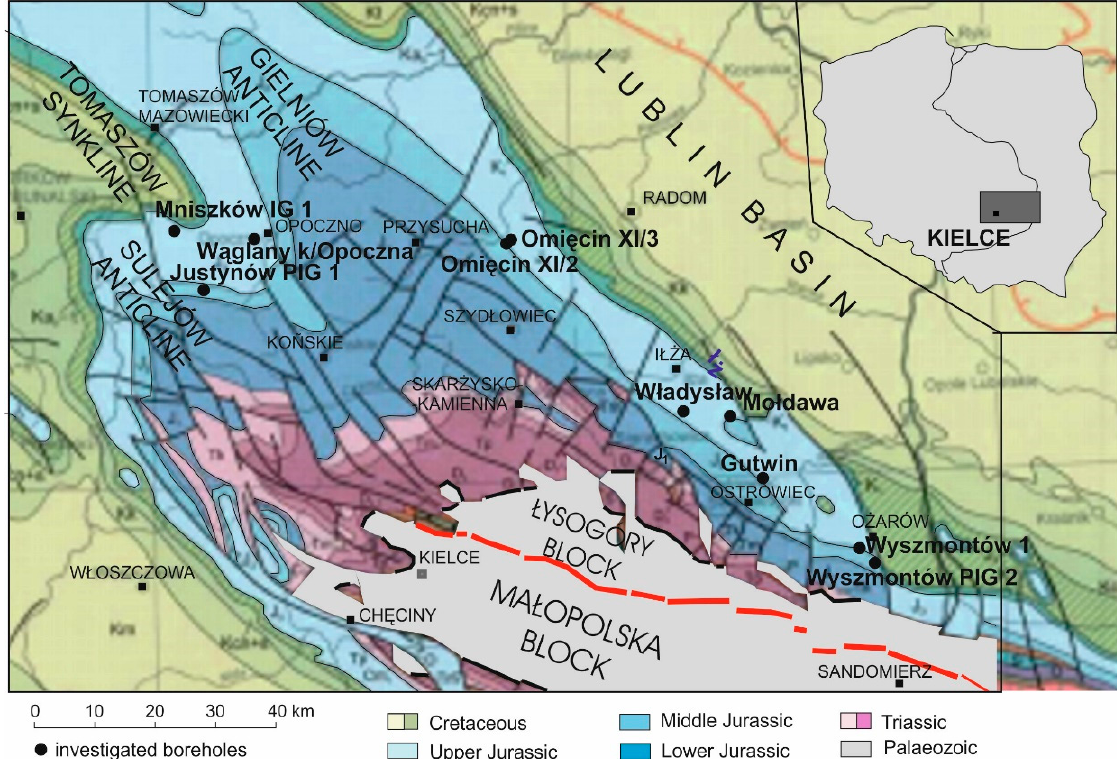
Figure 1. Location of boreholes on the background of the geological map without Cainozoic deposits (after Reference [56]).